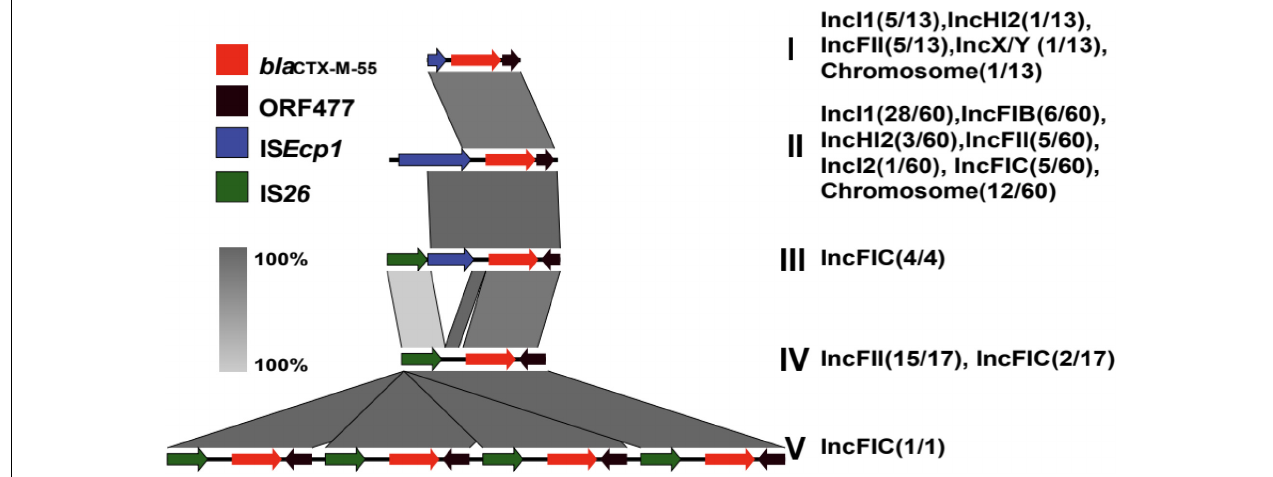
FIGURE 6 | Genetic environment surrounding the bla CTX − M − 55 gene. The colored arrow represents the ORFs and the arrow direction indicates the transcription direction. A total of 6 bla CTX − M − 55 genetic structures were obtained, and different genetic environments surrounding the bla CTX − M − 55 gene exist in different types of plasmids. The architecture of type I (13/95) is “ (cid:49) IS Ecp1 - bla CTX − M − 55 -ORF477”; type II (60/95) is “IS Ecp1 - bla CTX − M − 55 -ORF477”; type III (4/95) is “IS 26 - (cid:49) IS Ecp1 - bla CTX − M − 55 -ORF477”; type IV (17/95) is “IS 26 - bla CTX − M − 55 -ORF477”; type V (1/95) is “IS 26 - bla CTX − M − 55 -ORF477-IS 26 - bla CTX − M − 55 -ORF477- IS 26 - bla CTX − M − 55 -ORF477- IS 26 - bla CTX − M − 55